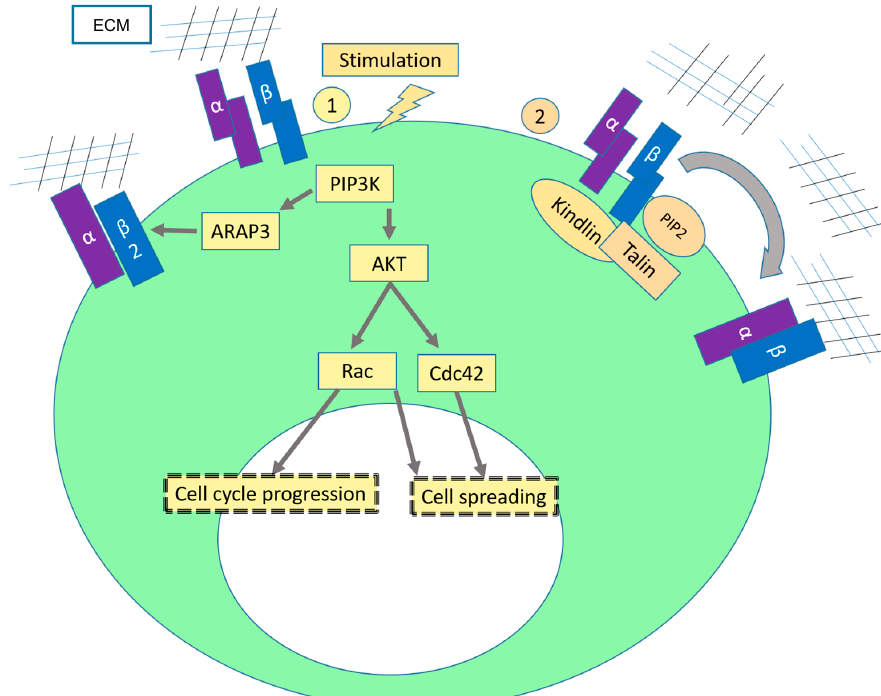
Figure 2. Inside-out Integrin mediated cell spreading. Cell spreading is described as the deformation of the plasma membrane due to extensions of protusions, leading to the adhesion between cell and substrate [44]. (1) Upon stimulation with cytokines, PI3K is activated. On the one side, PI3K activation phorphorylates AKT and the downstream effectors Rac and Cdc42 are activated [45]. These are small GTPases that are involved in the reorganization of the cytoskeleton which leads to the formation of lamelipodia and filipodia. On the other side, it was shown that PI3K induces activity of the β 2 integrin subunit via ARAP3 (Arf GAP and Rho GAP with ankyrin repeat and PH domain 3) [46]. ARAP3 is Rap-regulated GTPase-activating protein for RhoA and Arf6 which are resposible for actin modulation [47–49]; (2) Accumulation of PIP2 leads to the recruitment of talin to the plasma membrane, enabling a physical interaction between talin and the β 1 and β 3 integrin subunits which induces a conformational change in the integrin heterodimers that increases integrin affinity to its ligand. Kindlins are also essential for the inside-out activation of integrins [50]. In fibroblasts, kindlin-2 binds and activates FAK, inducing formation of lamellipodia [51]. Arrows: interaction with another protein or promotion of a specific cell behavior; T-bar: inhibition; dotted boxes: effect/consequence from the signaling cascade; big ellipse in green: cell; small ellipse in white: nucleus.